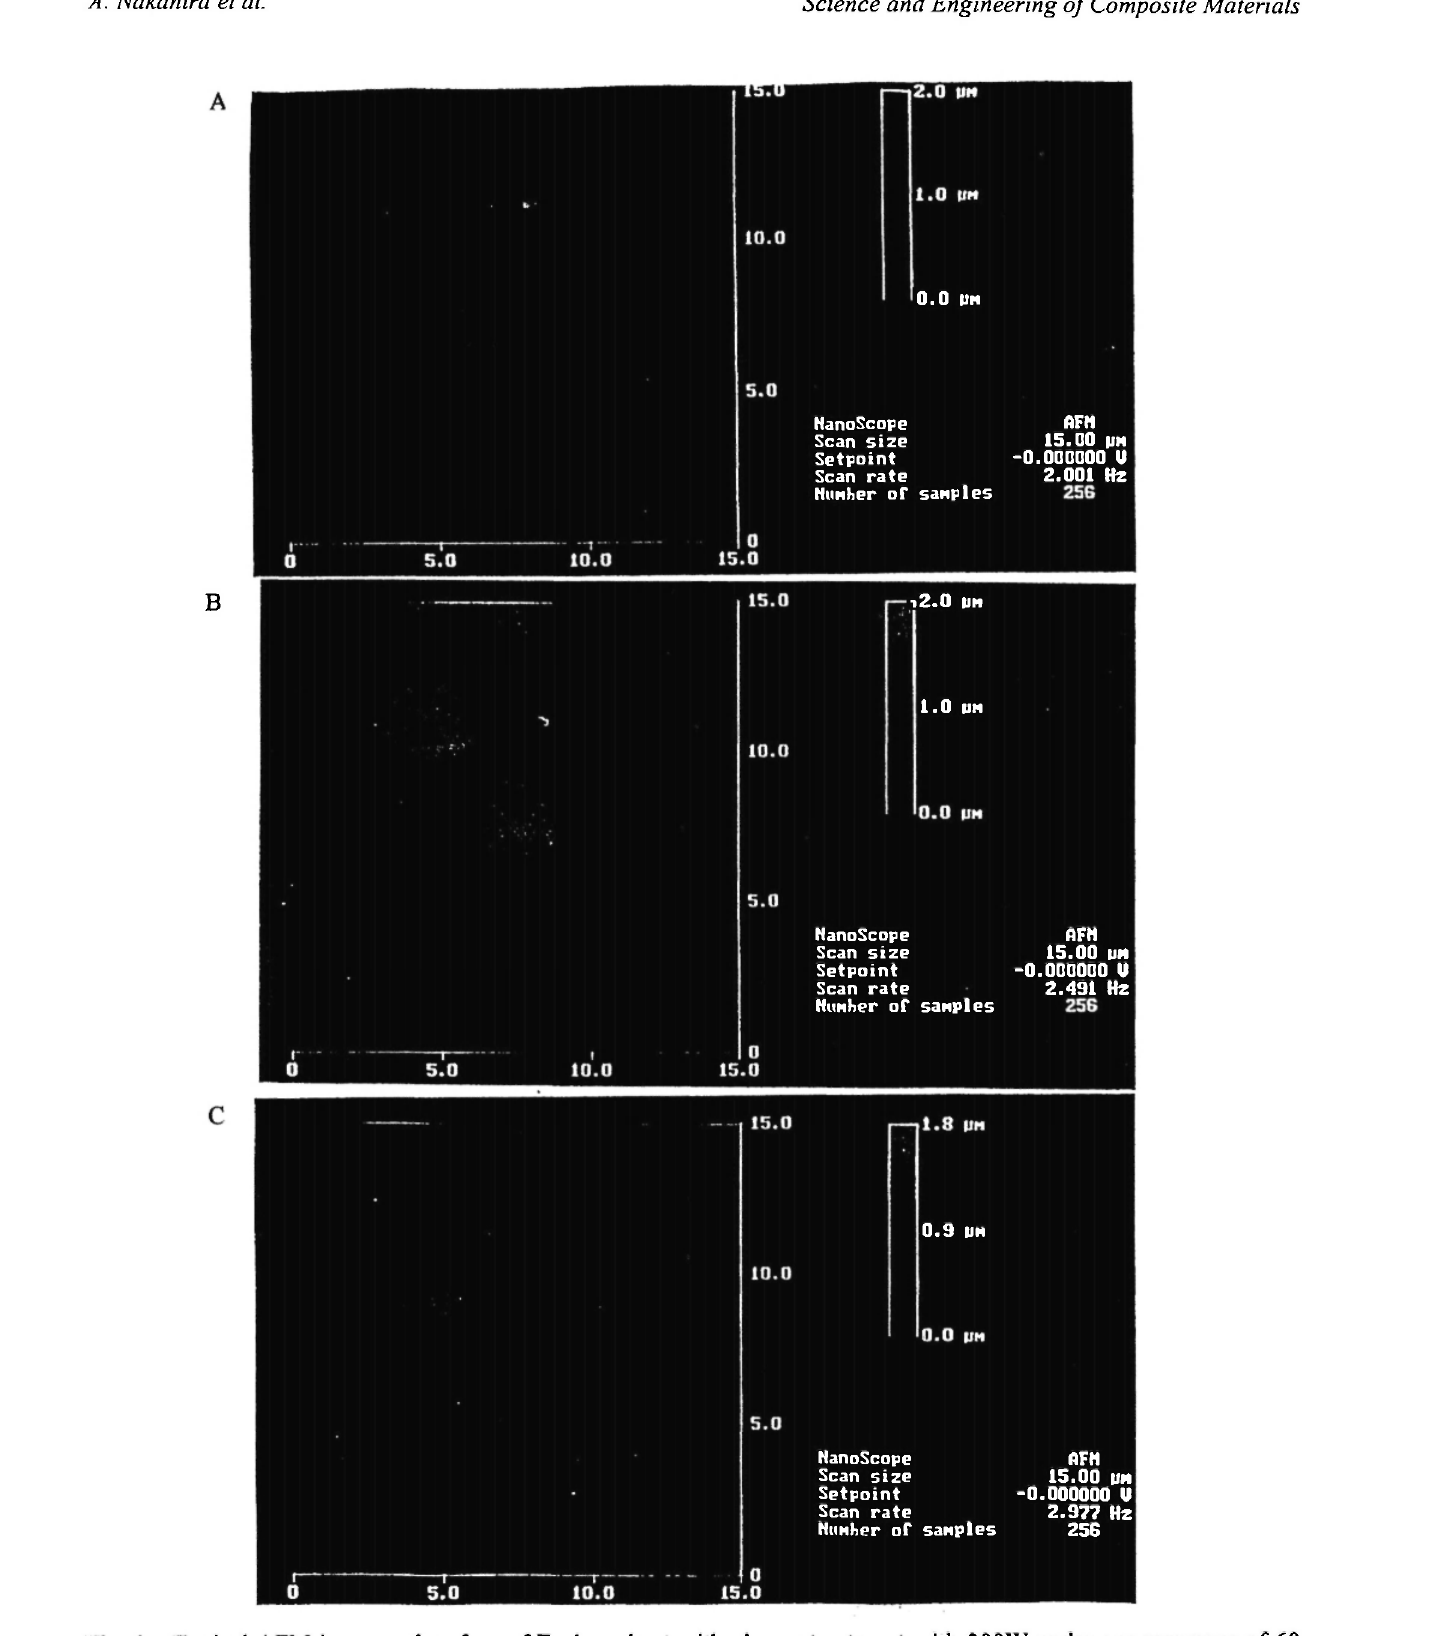
Fig. 4: Typical AFM images of surface of Ε-glass sheet with plasma treatment with 300W under gas pressures of 60 to 120 Pa: (A) as-polished, (B) 60 Pa, and (C) 120